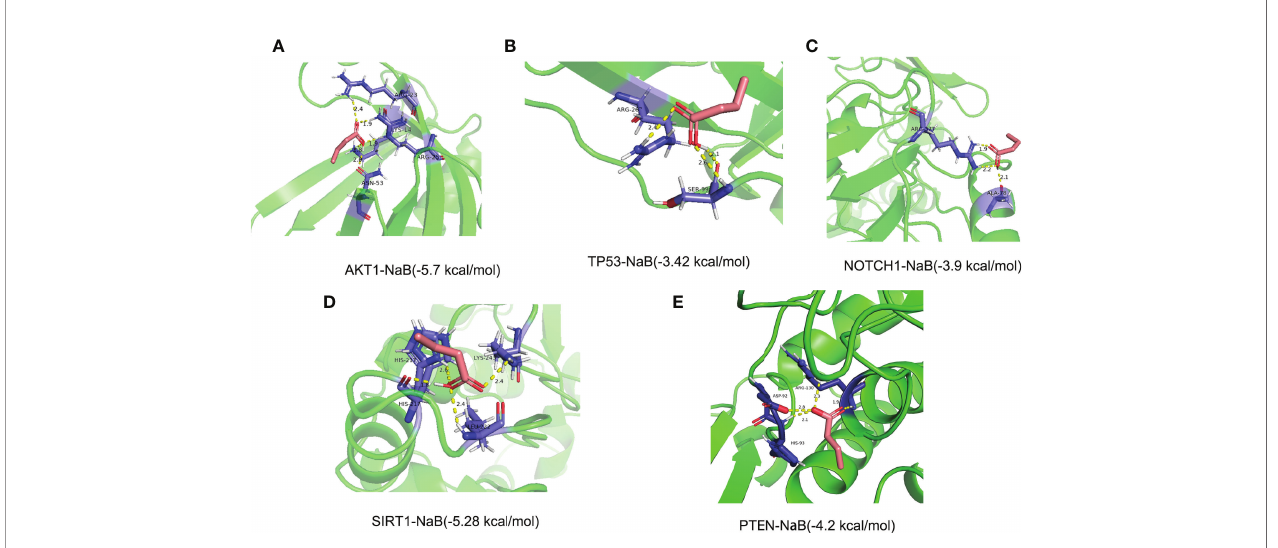
FIGURE 13 | Stereogram and docking energy score of molecular docking using AutoDock Vina tool and PyMOL software. (A) AKT1-NaB. (B) TP53-NaB. (C) NOTCH1-NaB. (D) SIRT1-NaB. (E) PTEN-NaB. The yellow dotted line represents the interaction between NaB and the target protein. NaB, sodium